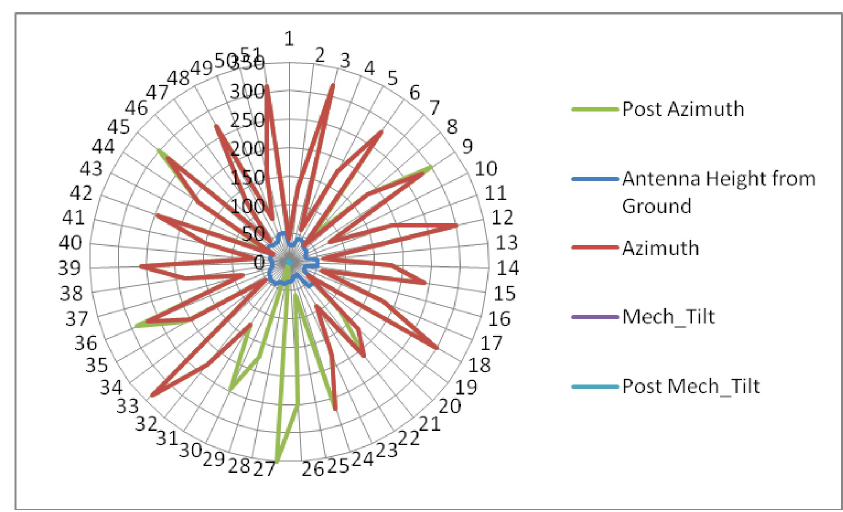
Figure 9. Comparison of effects of azimuth and mechanical with post-azimuth and post mechanical tilts for the antenna height from the ground for the test scenario.